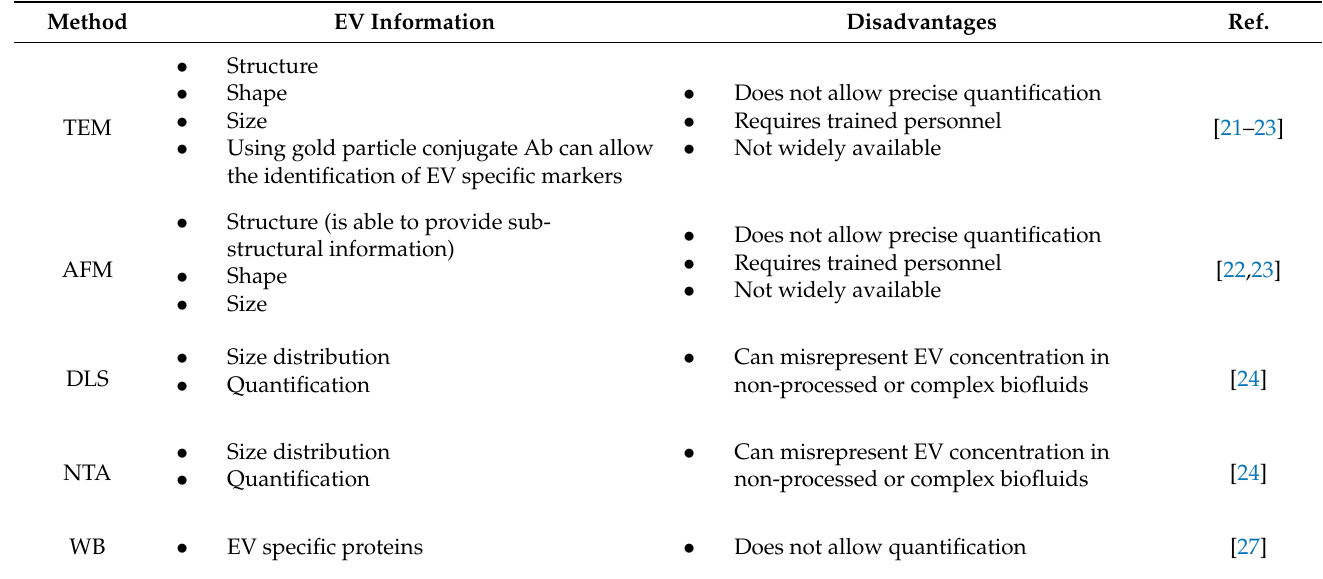
Table 2. EV characterization